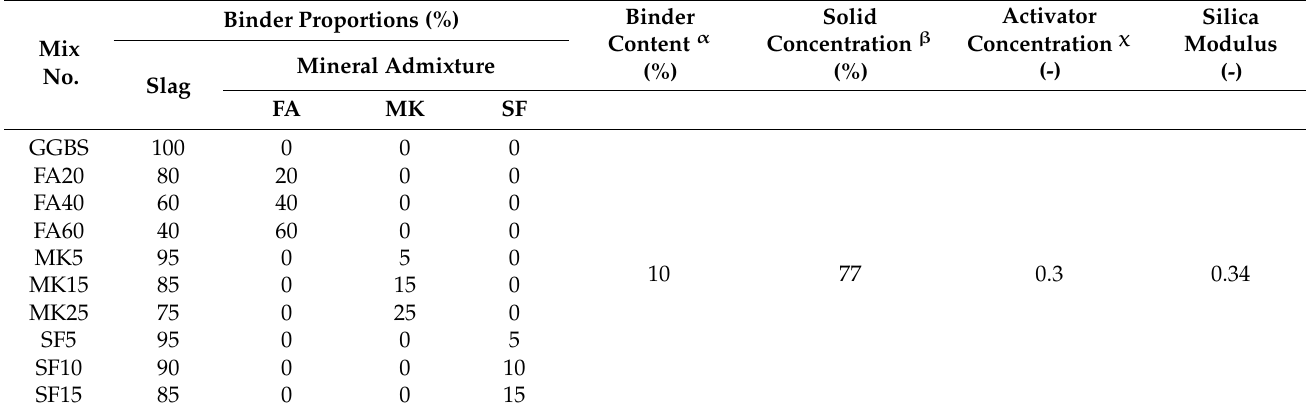
Table 3. Details of the mix proportions.